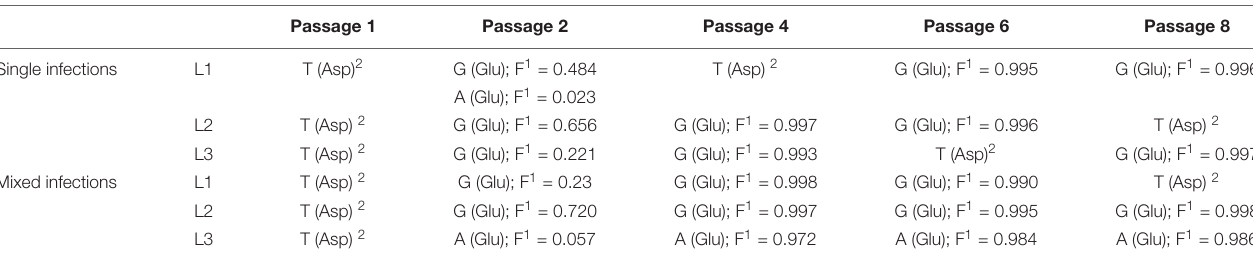
FIGURE 6 | Number and position of mutations identified for the PepMV-EU (A) and PepMV-CH2 (B) genomic regions sequenced at each passage for single and mixed infections (see diagram in Figure 5A ). On the left, the number of mutations, total, non-synonymous (NS), and synonymous (S). Each point represents a mutation and its size represents its frequency; in black, non-synonymous (NS) and in white synonymous (S) substitutions. TABLE 4 | Allele found at position 1312 of the PepMV-CH2 RdRp coding